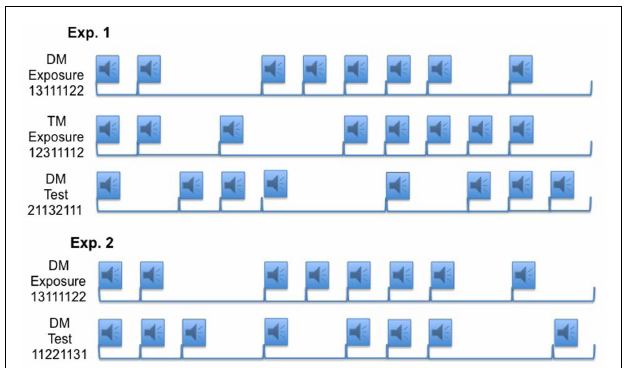
FIGURE 1 |A representation of the stimulus design, where the audio symbol indicates a syllable presentation (218ms) and the brackets represent the assigned time intervals (interval times: 1 = 700ms, 2 = 1400ms, 3 = 2100ms). For every syllable presentation one of three syllables (PA,TA, or KA) was presented according to a pseudo-randomized order.The exposure-timing pattern is presented for Blocks 1–5 and 7.The test pattern is presented in Block 6.There are 12 repetitions of the rhythm per